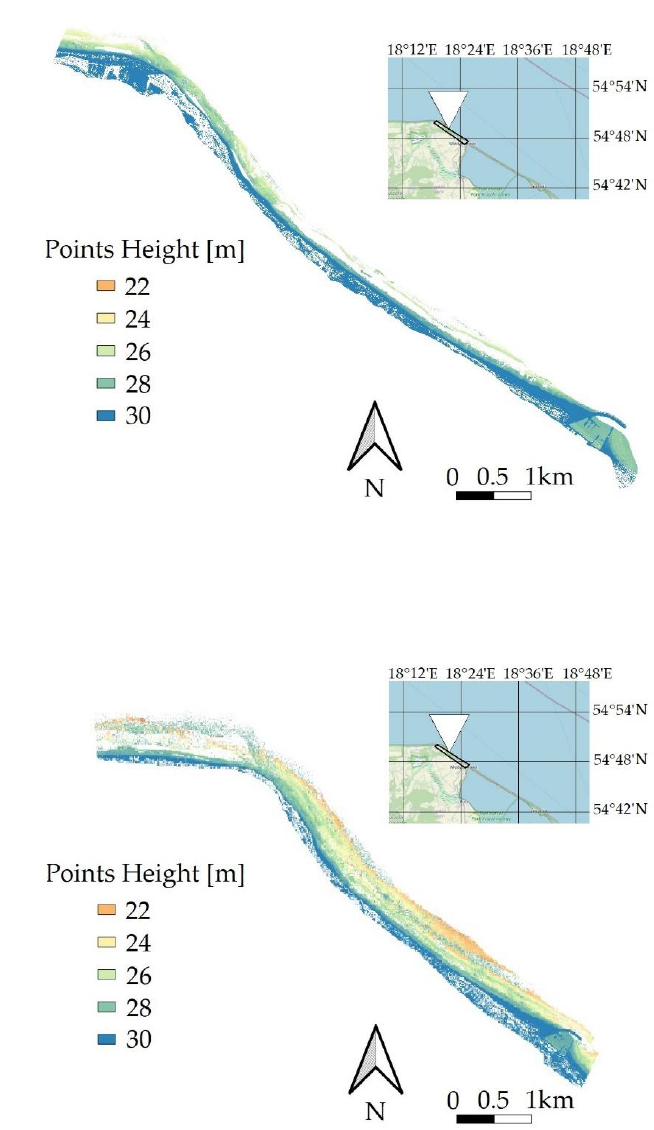
Figure 9. The di ff erence in registration possibilities for the bathymetric scanner that is able to collect bottom information for ( a ) conditions 3–4; and ( b ) conditions